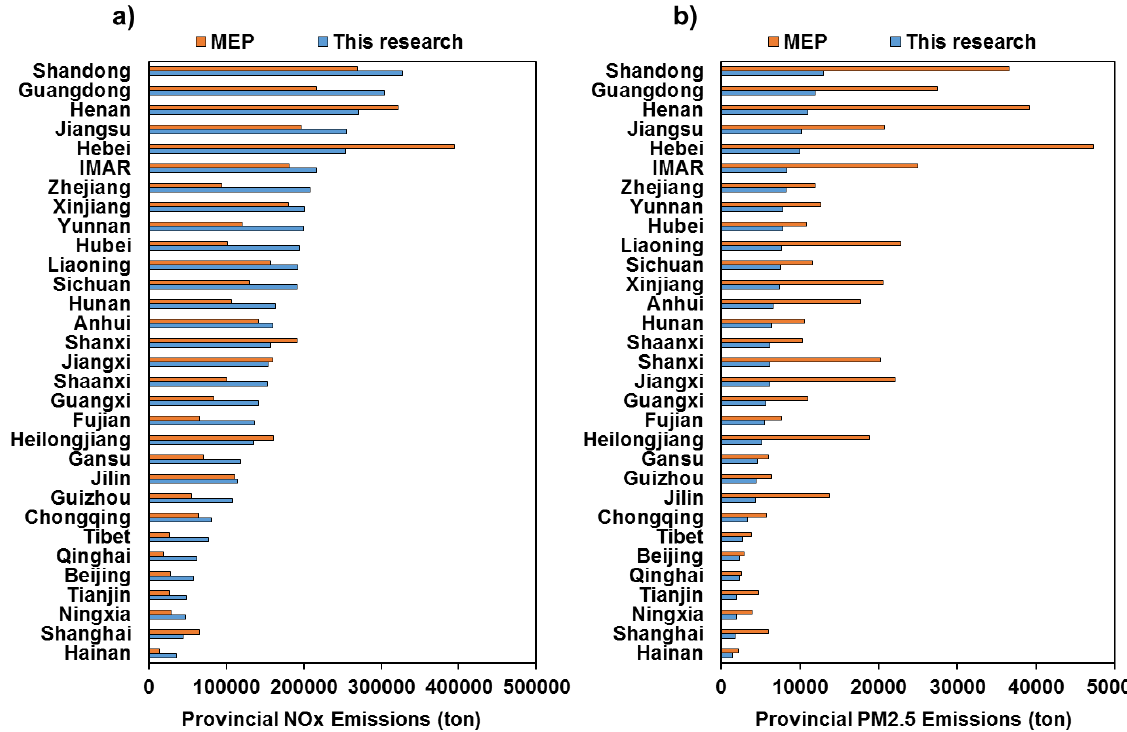
Figure 10. Provincial diesel-truck emissions from this study and MEP inventories: (a) NO x emissions ranks and (b) PM 2 . 5 emissions ranks (ranking according to emission scales in this